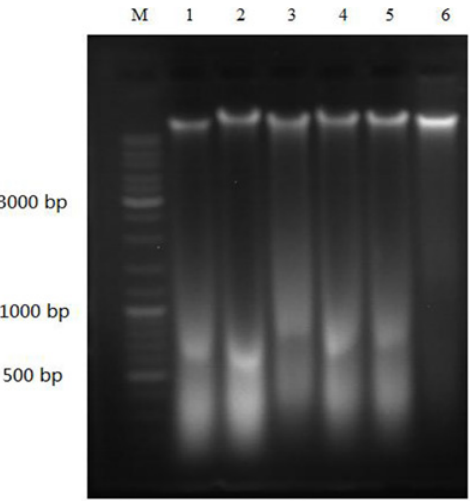
Fig 6. Fragmentation analysis by agarose gel electrophoresis. Lane M: DNA Ladder; Lane 6: Control; Lanes1, and 2: Cells treated with 3.0 μ M and 6.0 μ M Cisplatin; Lanes 3, 4 and 5: Cells treated with 2.5 μ M, 5.0 μ M and 10.0 μ M EM-d-Rha,